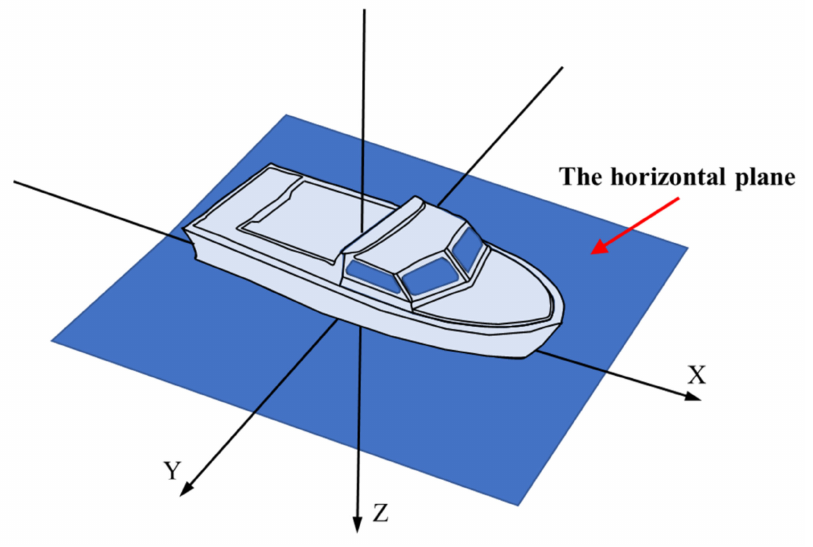
Figure 1. The definitions of the vessel frame system [7].